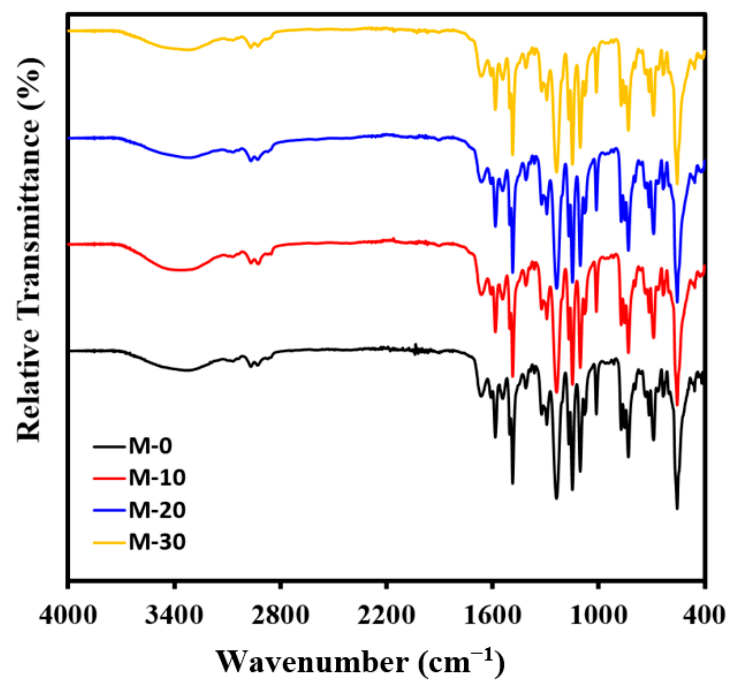
Figure 3. Complete FTIR Spectra of M-0, M-10, M-20 and M-30 membranes.